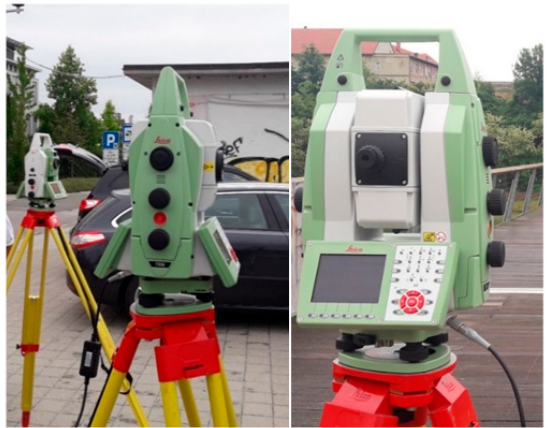
Figure 2. Geodetic instruments Leica TS30/50 for monitoring.